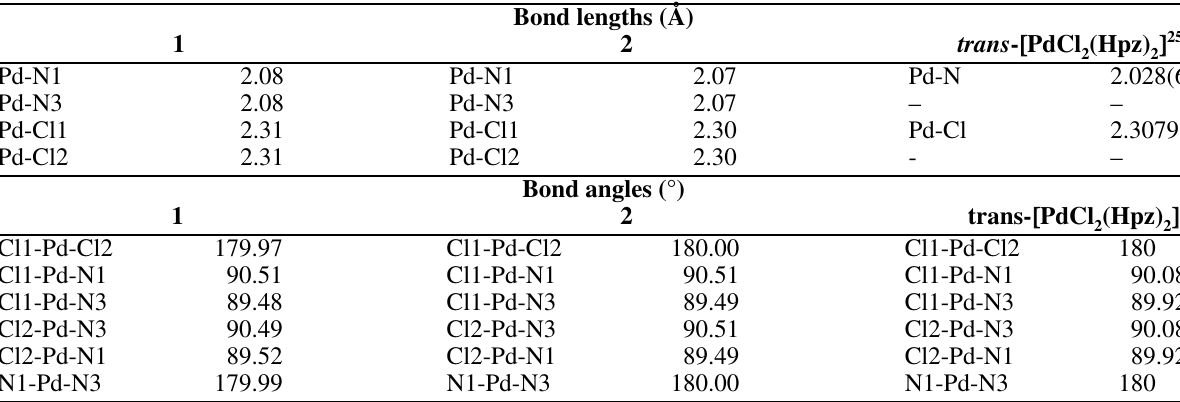
Figure 1. Computed structure of [ PdCl Table 1. Selected calculated bond lengths (Å), bond and torsion angles (°) for [ PdCl ] . 25 Cl (Hpz) 2 2